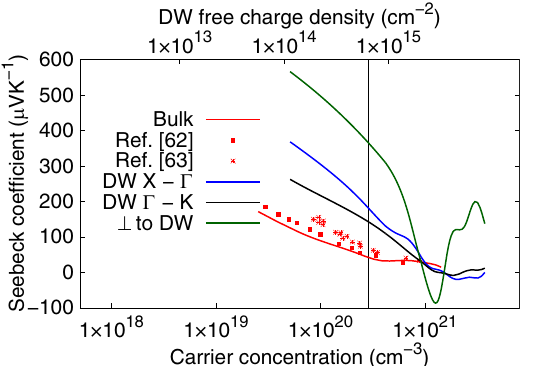
Fig. 5 Seebeck coef fi cient of the tail-to-tail domain wall. Calculated Seebeck coef fi cient for p-type bulk GeTe and 39° (11 1 ) tail-to-tail (T-T) domain walls (DWs) for various directions at 300 K. Experimental data for bulk GeTe from refs. 62,63 are shown by red squares and stars, respectively. The top x -axis shows the DW interface free charge density, while the bottom x -axis corresponds to the volume charge concentration for the DW separation of 5.6 nm. Black vertical line shows the intrinsic doping concentration of the T- T DW for this DW separation due to charge transfer between the head-to-head and T-T